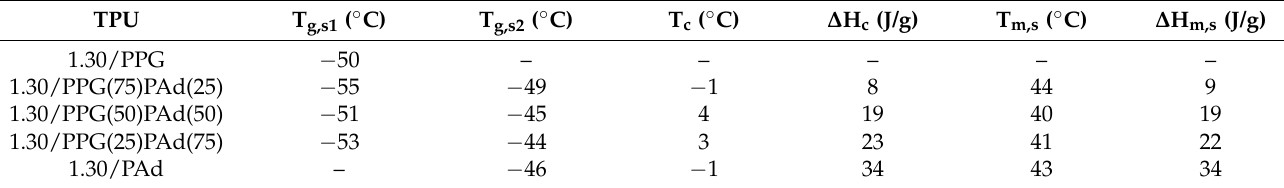
Figure 6. X-ray diffractograms of the TPUs synthesized with PPG+PAd blends. TGA has been used for assessing the structural features of the polyurethanes [37].